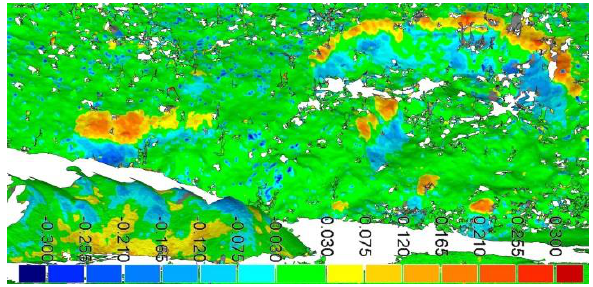
Figure 4: Deformation analysis [m] based on TLS measurements between reference and last